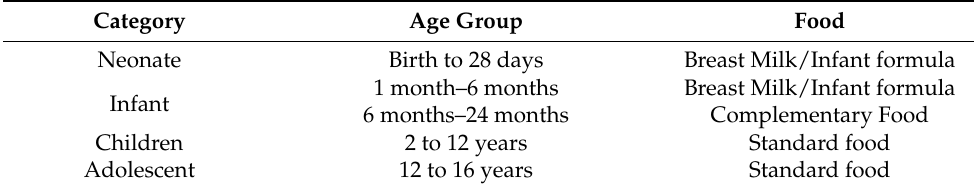
Table 1. Different stages of child development and type of food required